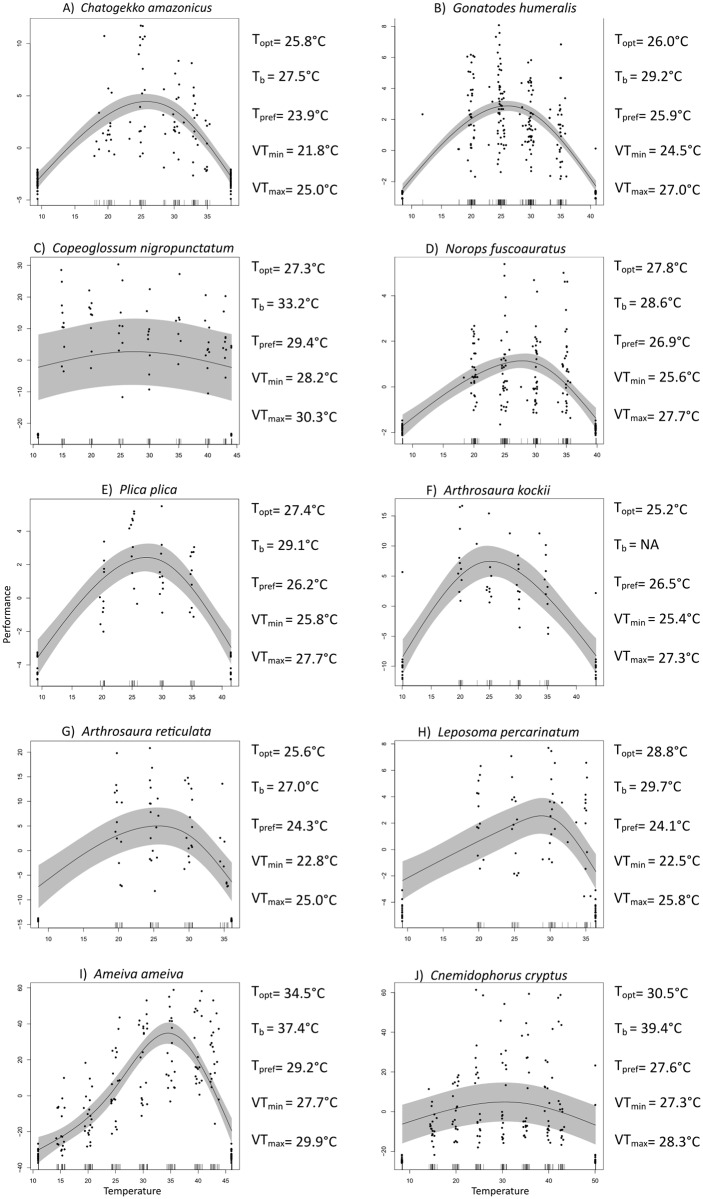
Thermal-performance curves and mean values of thermal traits.A) Chatogekko amazonicus; B) Gonatodes humeralis; C) Copeoglossum nigropunctatum; D) Norops fuscoauratus; E) Plica plica; F) Arthrosaura kockii; G) Arthrosaura reticulata; H) Leposoma percarinatum; I) Ameiva ameiva; and J) Cnemidophorus cryptus. Gray shaded region shows the 95% confidence interval. Black points represent the results of individual tests at different body temperatures: 15°, 20°, 25°, 30°, 35°, 40° and 43° for species classified as thermoregulators and 20°C, 25°C, 30°C and 35°C for shade-associated species classified as thermoconformers. Short vertical black lines indicate the number of trials at each temperature. Black lines at the curves’ extremes are the critical thermal minimum (CTmin) and critical thermal maximum (CTmax). Topt = optimal temperature; Tb = body temperature; Tpref = preferred temperature; VTmin = minimum voluntary temperature; VTmax = maximum voluntary temperature.